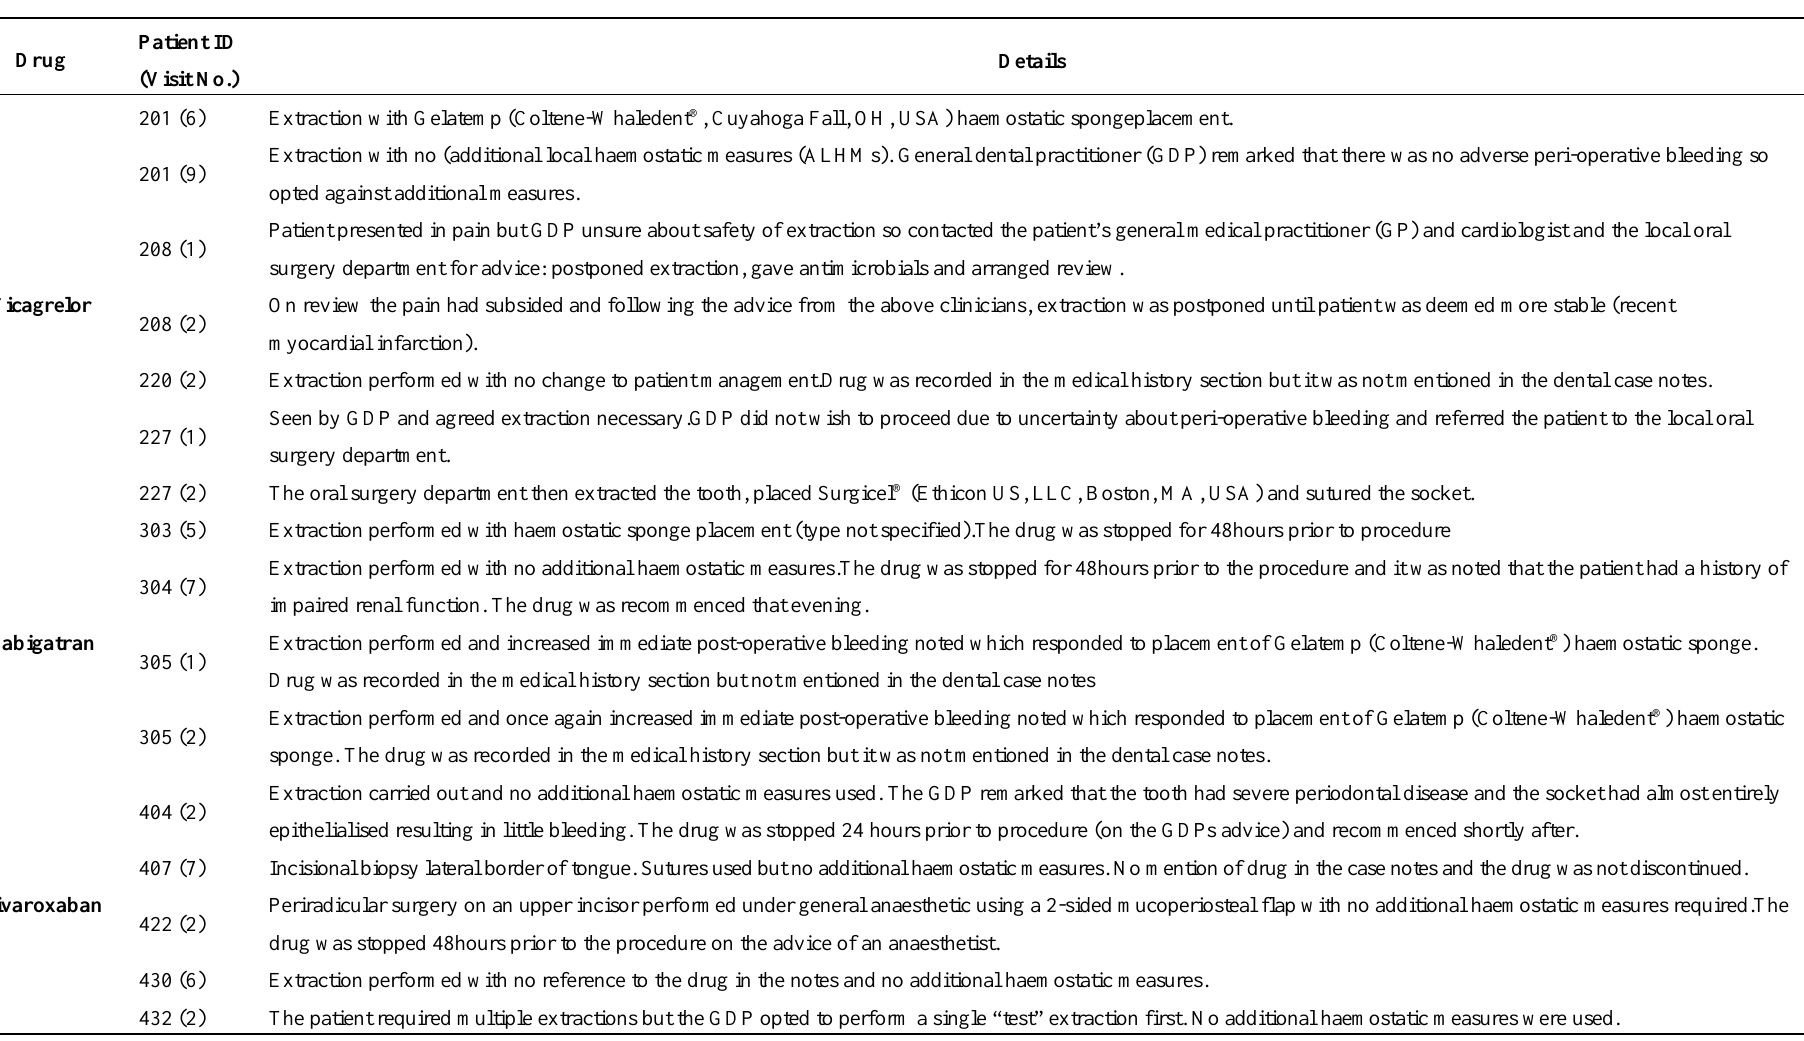
Table 2. Notable interventions and specific treatment